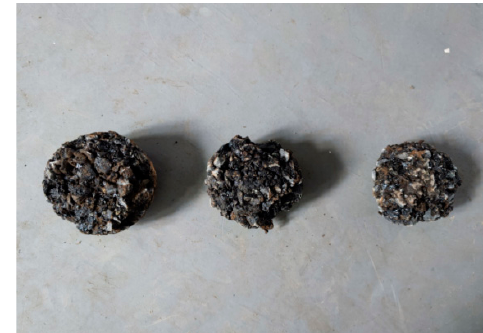
Figure 2. Specimens in the freeze–thaw cycle test.